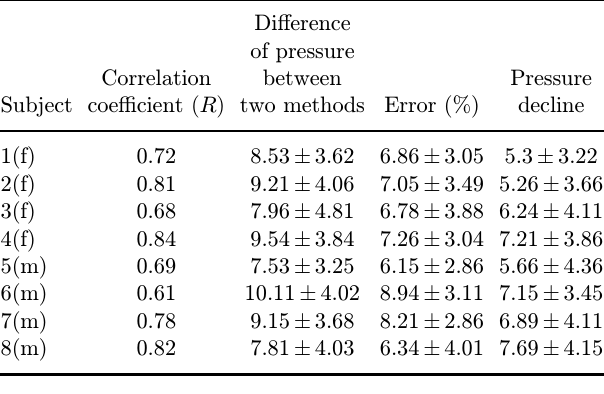
Fig. 6. Bland – Altman plots demonstrating the overall agree- ment between the BP cuff and the BP PTT in all eight sets of data by using each normal subject's individual linear function parameters. The outer lines indicate the limits of agreement, the inner line represents the mean di®erence.